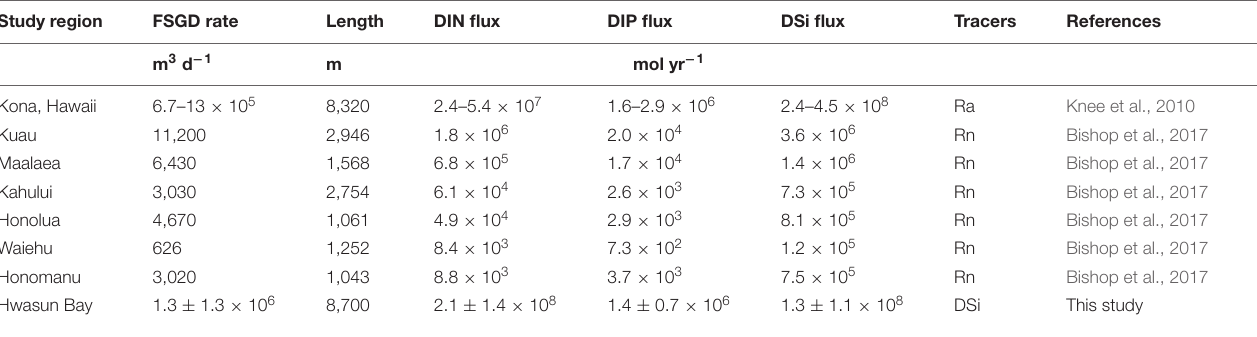
TABLE 2 | The summaries of the geochemical tracer based fresh submarine groundwater discharge (FSGD) estimates and the associated nutrient fluxes to the coastal zones of volcanic islands (Jeju and Hawaii). Study region FSGD